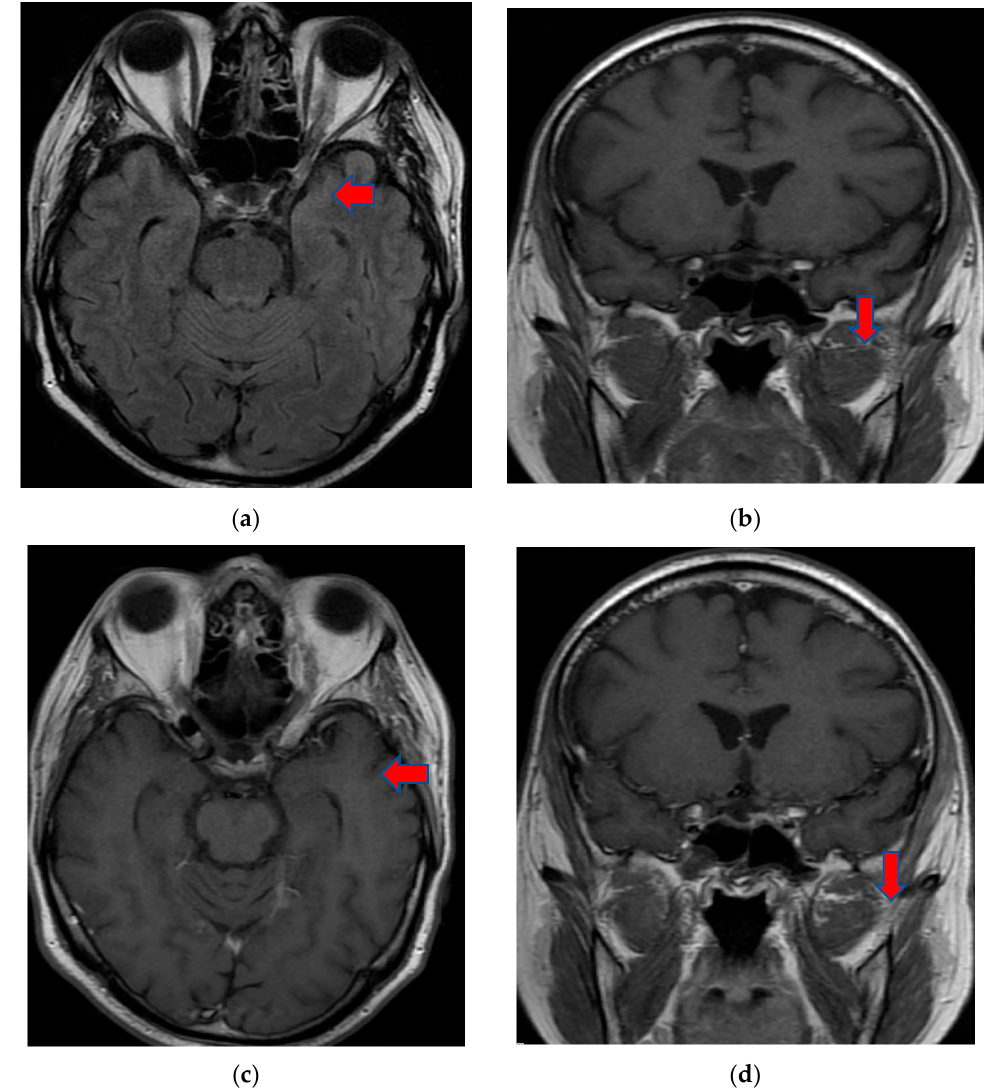
Figure 1. MRI T2 axial Flair ( a ) and coronal T1 FSE ( b ) images demonstrated perineural tissue extending into the left cavernous sinus. Postcontrast T1 axial FSE ( c ) and coronal T1 FSE ( d ) images showed an inflammatory process involving the left cavernous sinus and orbital apex with perineural enhancement surrounding the left optic nerve sheath. MRI: magnetic resonance imaging; Flair: fluid attenuated inversion recovery; FSE: fast spin-echo.